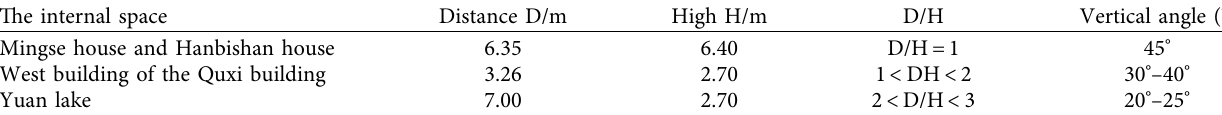
Table 1: Types of classical garden